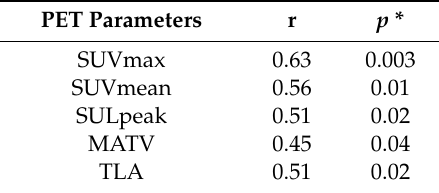
Table 2. PET-derived parameters and PSA levels at baseline: regression